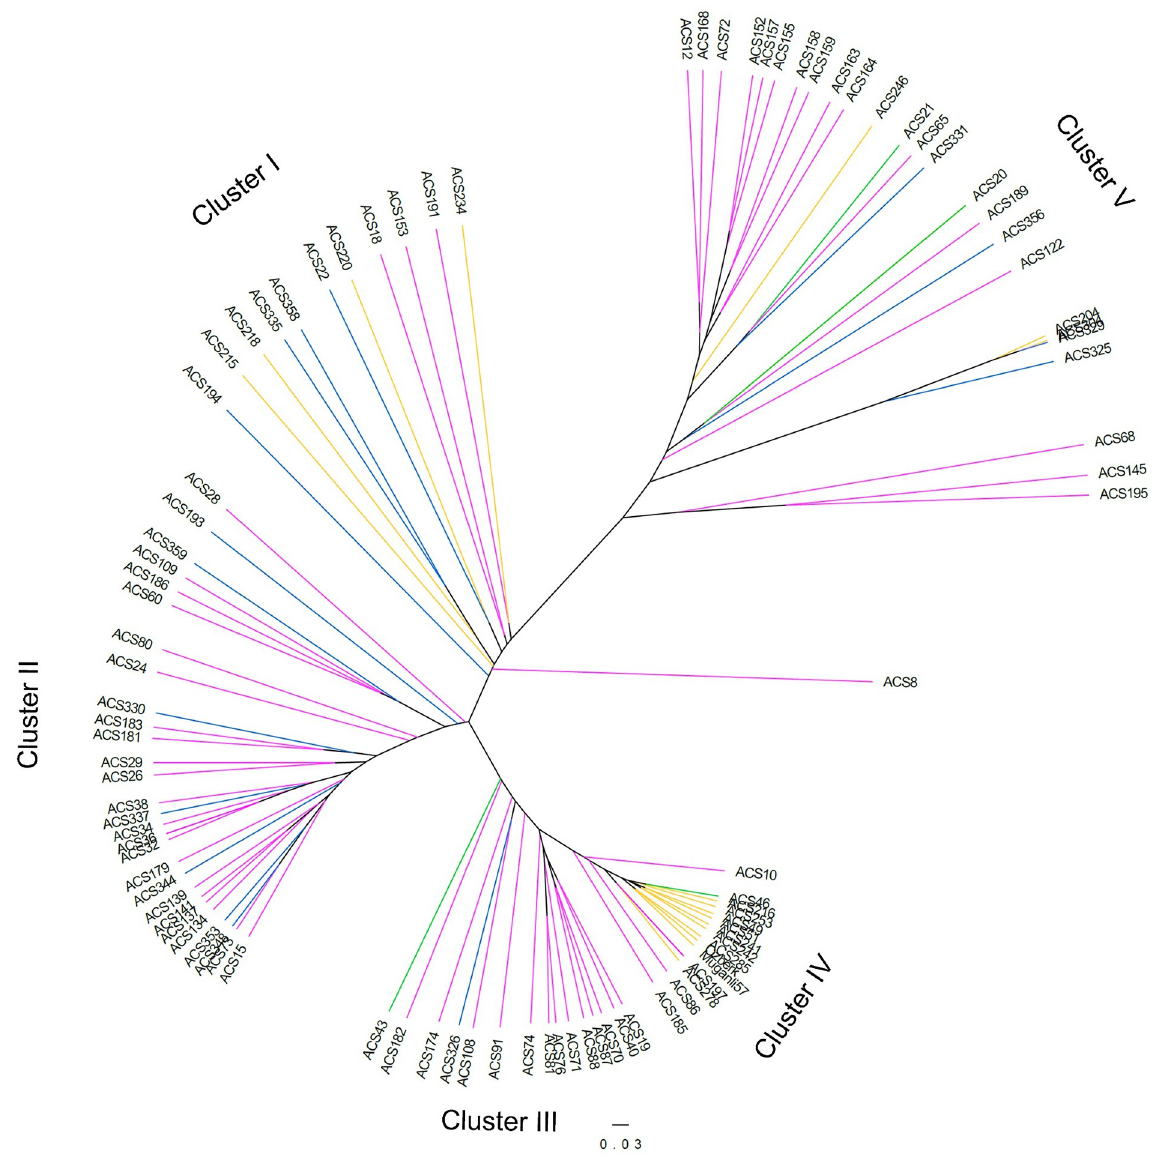
Fig 2. UPGMA based dendrogram generated using 5292 SNPs and 95 sesame accessions. The colors of pink, green, blue and yellow represent continental origins of accessions. Pink is Asia; Green is Africa; Blue is America; Yellow is Europe.